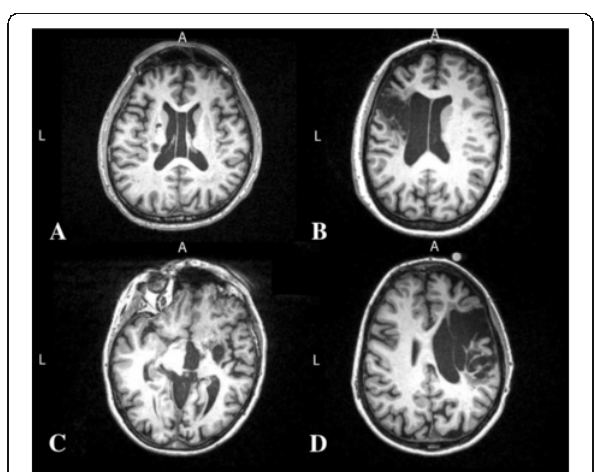
Fig. 12 (abstract A14). A Comparison Across Different Stroke Lesion Profiles at Maximum Lesion. MRI scans of individuals who sustained a subcortical left-hemisphere stroke, b cortical left-hemisphere stroke, c subcortical right-hemisphere stroke, d cortical right-hemisphere